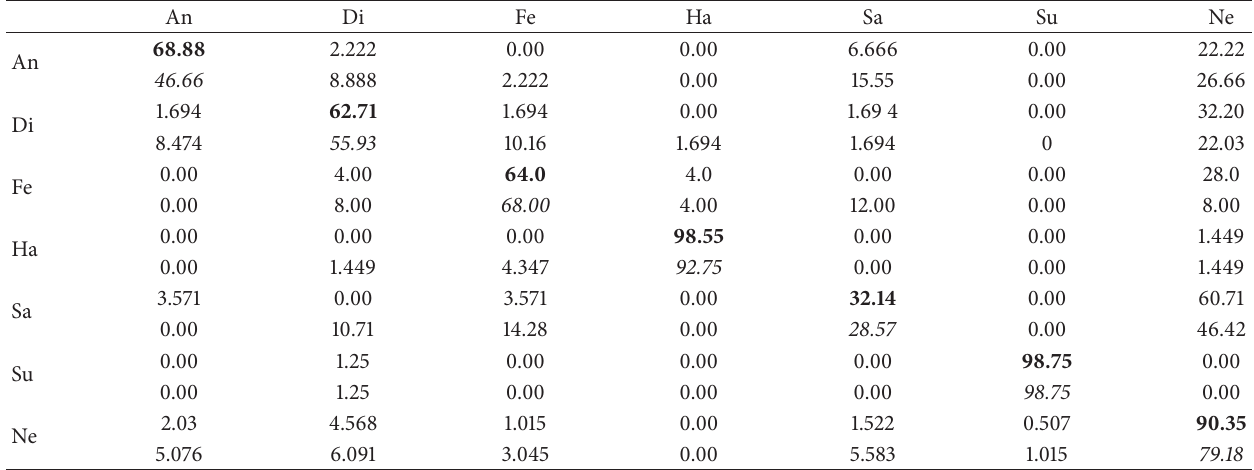
Table 3: The confusion matrix obtained by applying our approach on CK+ database. The first row in each expression represents results using SVM classifier. The other row shows the results using KNN